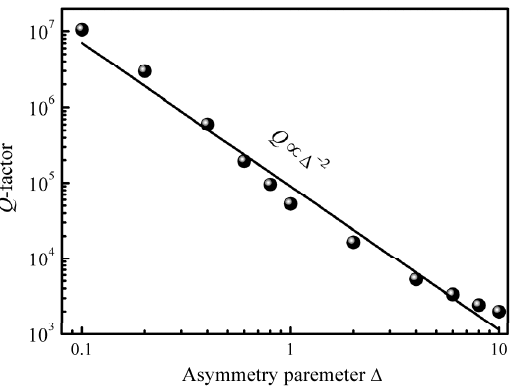
Figure 3. Plot of Q-factor of mode 2 as a function of the asymmetric parameter ∆ (log-log scale), where the black points are obtained by the simulation method and the black line is fitted to demonstrate the inverse quadratic dependence of ∆